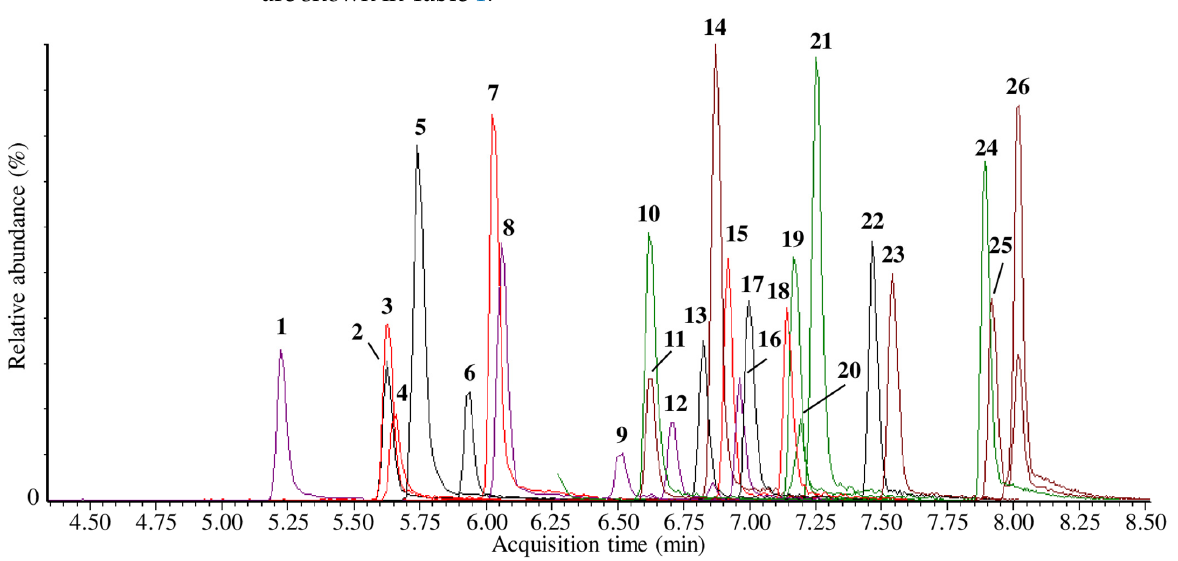
Figure 2. An overlay of extracted MRM chromatograms for all analytes. Analyte numbers are shown in Table 1. Table 1. Retention time (Rt), precursor ion, product ions (quantifier ions in bold), cone voltage (CV), collision energy (CE) and dwell time for each target analyte.